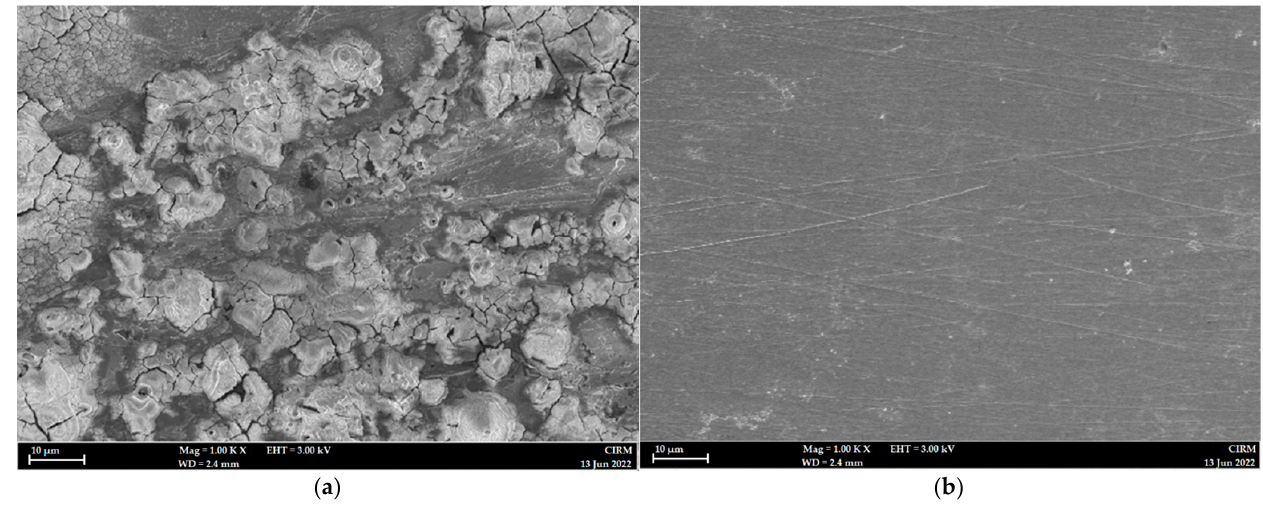
Figure 10. SEM photographs of mild steel samples in the absence ( a ), and presence of 0.5 mM nico- tinehydrazide derivative ( b ) in 1 M HCl at 303 K.